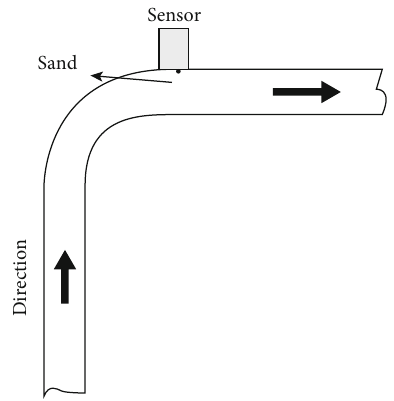
Figure 1: Principles of sand vibration